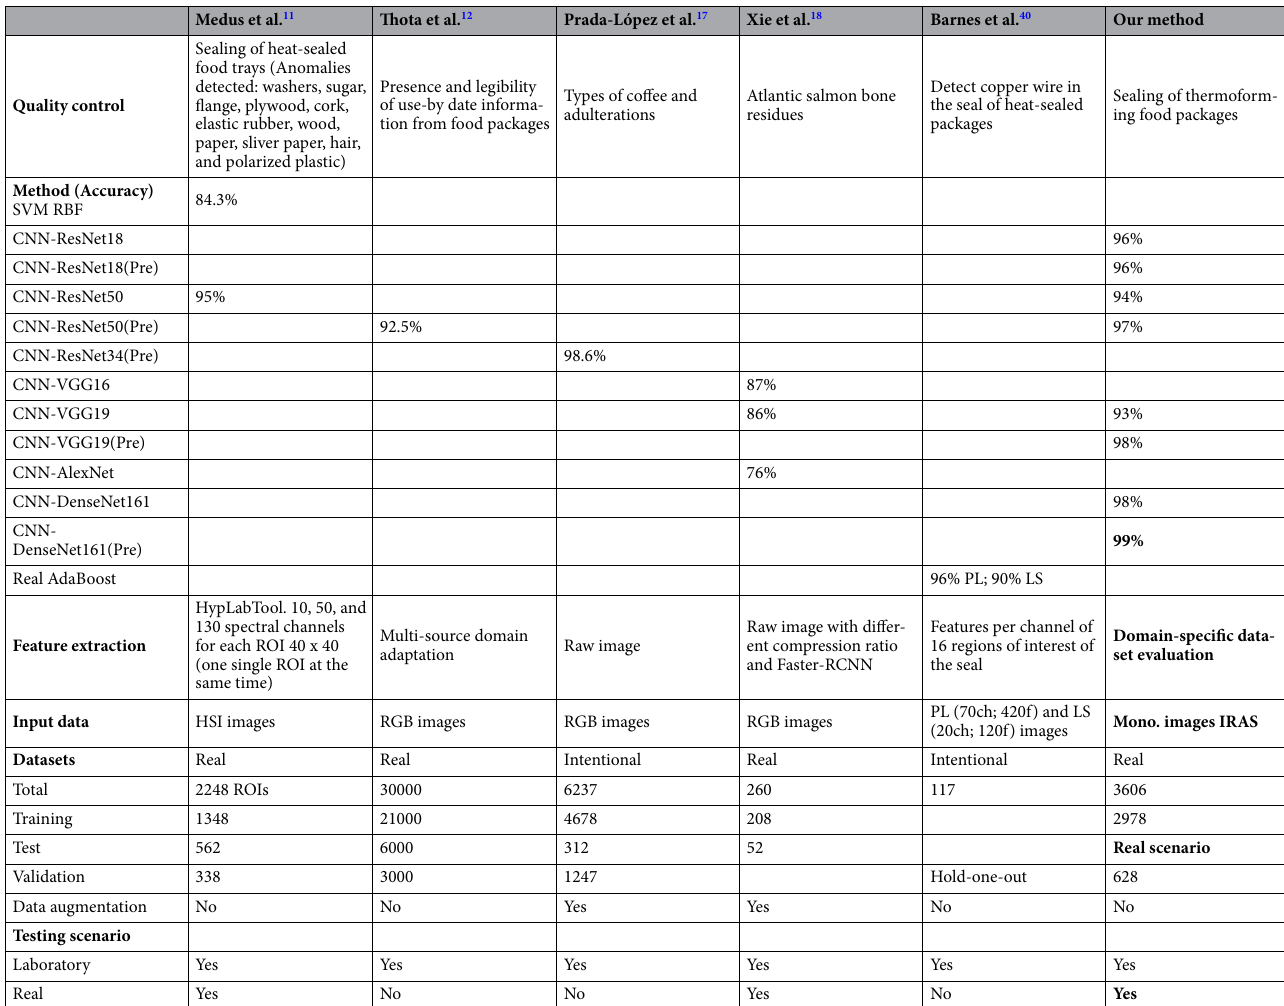
Table 1. Comparison of some state-of-the-art methods, including our proposal in the last column. SVM = Support Vector Machine, RBF = Radial Basis Function, CNN = Convolutional Neural Network, Pre =